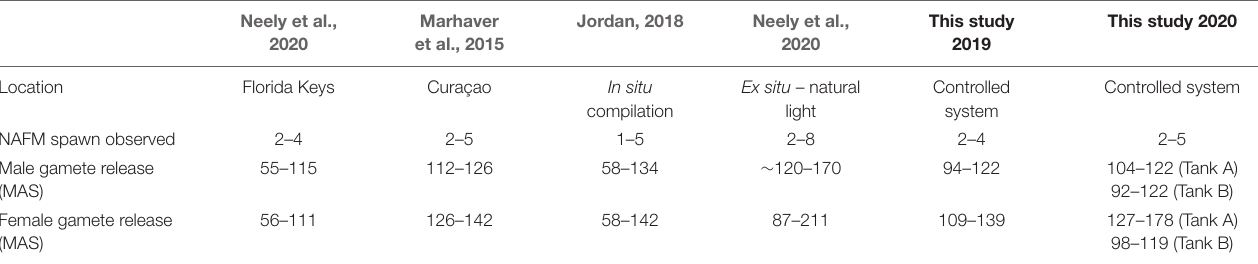
FIGURE 3 | Daily spawn timing in D. cylindrus colonies held in controlled systems. Each point represents a single colony. (A) colonies held in Tank A and Tank B during 2019 under the “normal” day/night program. Dashed line represents a period in which 7 additional colonies (6 female and 1 male) spawned without exact times recorded, while adjacent points correspond to the first and last colonies to spawn. (B) colonies held in Tank A during 2020 with an added period of twilight between day and night. (C) colonies held in Tank B during 2020 with the month of March removed from the programmed annual cycle. TABLE 1 | Previously reported in situ spawning observations for D. cylindrus compared with those observed in controlled systems over 2 years in the present